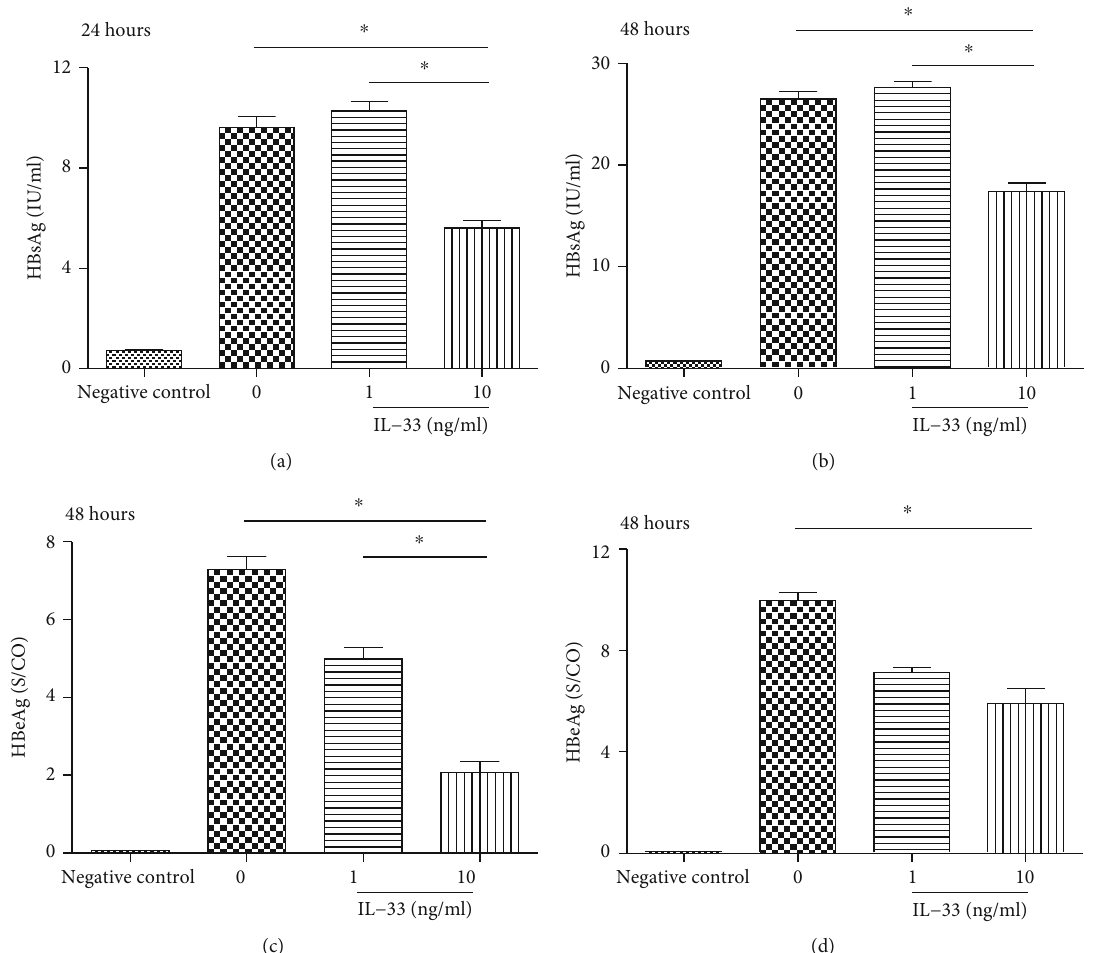
Figure 5: E ff ect of IL-33 on the secretion of HBsAg and HBeAg in the HepG2 cell line transfected with pAAV-HBV 1.2. After treatment with di ff erent concentrations of IL-33 (0, 1, and 10ng/ml) for 24 and 48 hours, HBsAg in the supernatant decreased in a dose-independent manner (a, b); HBeAg in the supernatant signi fi cantly decreased in a dose-independent manner (c, d). The statistical signi fi cance of the data was determined using the Mann – Whitney test; P value is shown in each